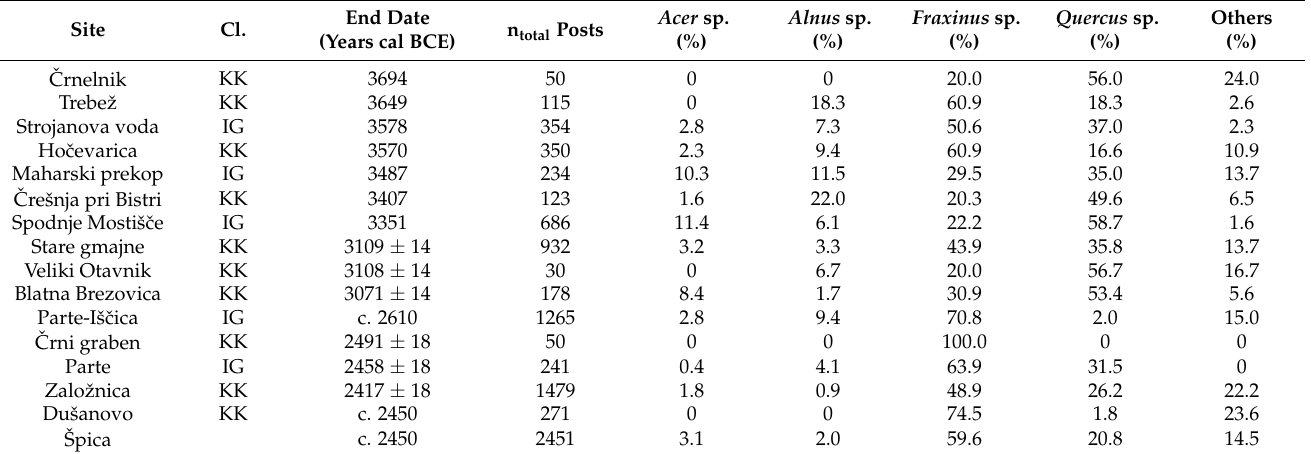
Table 2. The post wood identifications of the four dominant taxa for each of the studied sites in %. The sites are chronologically ordered (see Table 1). Cl.= cluster, KK = Kamnik pod Krimom, IG = Ig; Others = Abies sp., Corylus sp., Carpinus sp., Fagus sp., Populus sp., Salix sp., Ulmus sp. and a few samples that were not identified due to poor